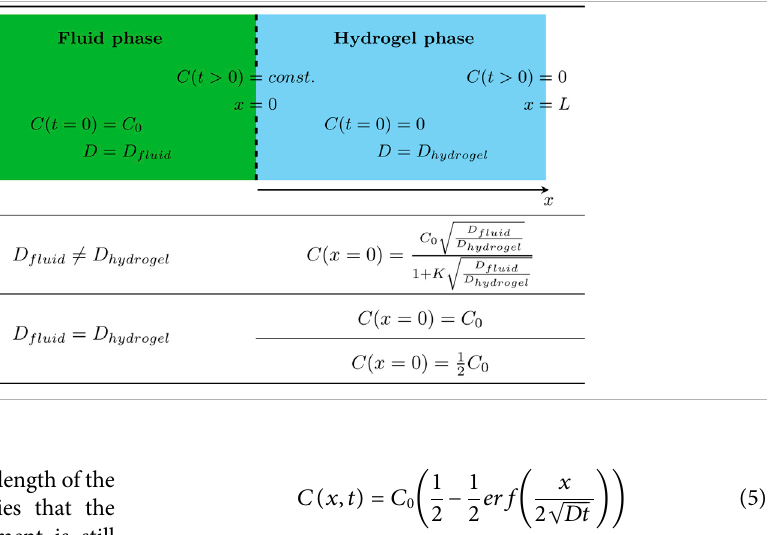
TABLE 1 | Summary of the general assumptions and the boundary and initial conditions of the applied